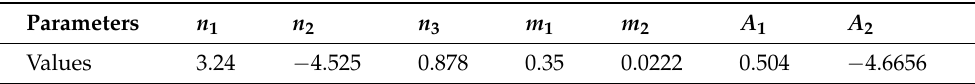
Table 1. Values of parameters involved in the mathematical model for the rolling of ships given in Equation